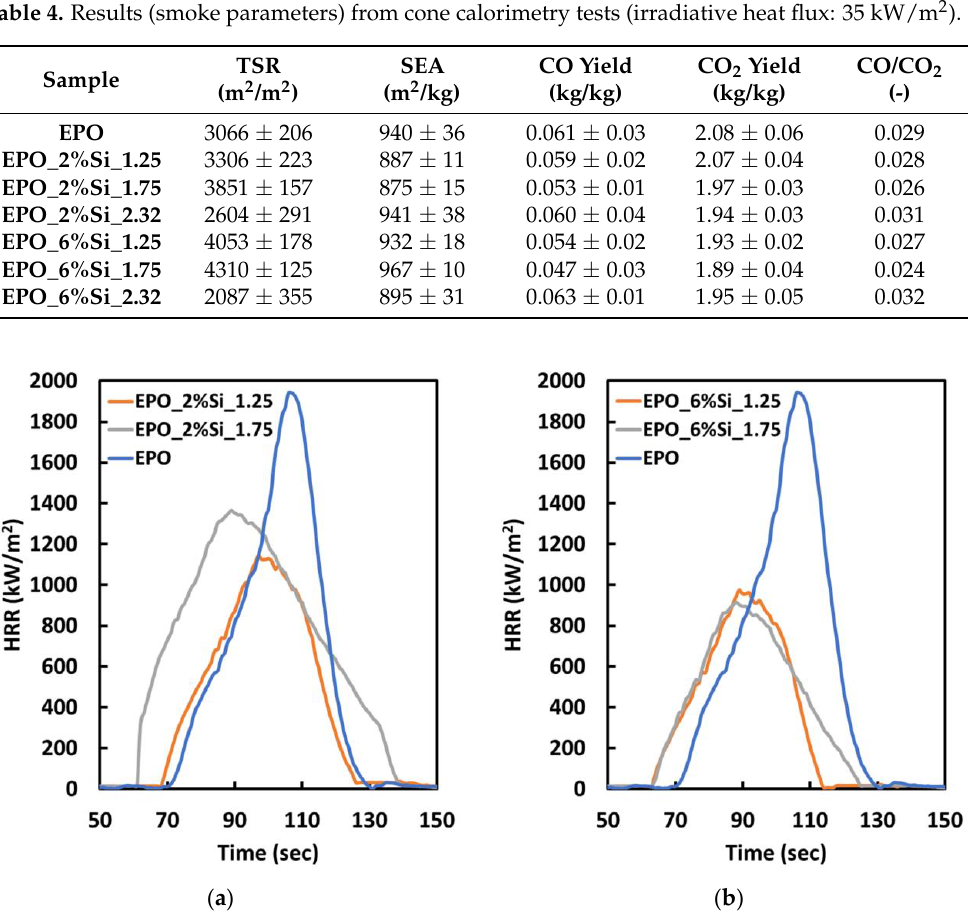
Figure 5. Typical HRR curves vs. time for EPO and some nanocomposites containing ( a ) 2 wt.% of silica and ( b ) 6 wt.% of silica, at different TEOS/APTS ratios. It is worth noting the effect of the TEOS/APTES molar ratio on the HRR values: as